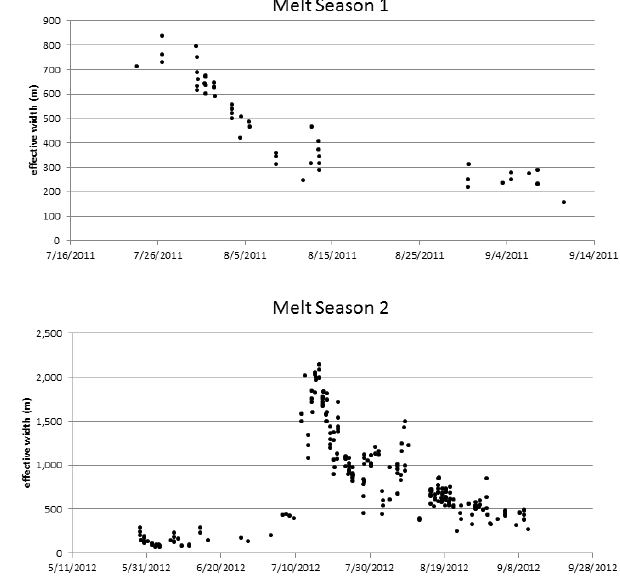
Figure 4. Successful image classification allowed for extraction of W e across two melt seasons from the wide angle camera and gives a proxy for discharge in the braided Isortoq River. Twenty-two statis- tical outliers, representing poorly classified images, were removed before generating this figure. These W e time series clearly show his- toric flooding in Greenland in July 2012, as well as the abrupt start of the 2012 melt season, and suggest that the camera platform and semi-automated classification techniques advanced here are suffi- cient for monitoring of this remote